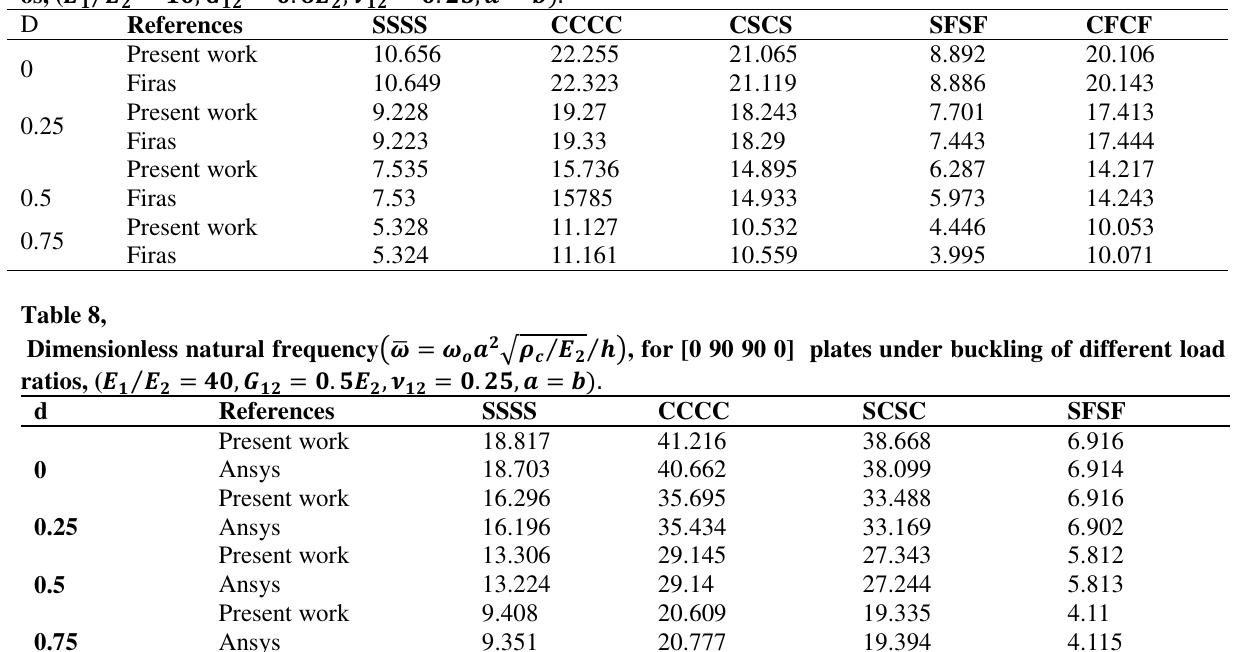
Dimensionless natural frequency , for [0 90 0] plates under buckling of different load rati-